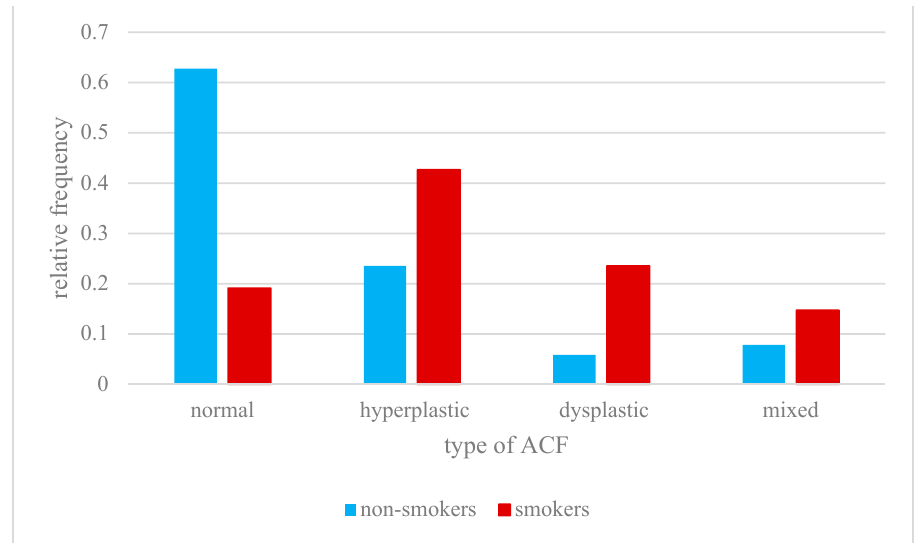
Figure 5. Occurrence of ACF types in the study group.